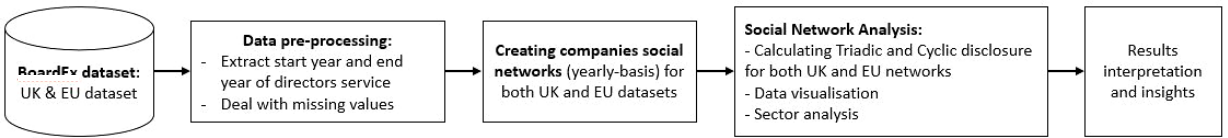
Figure 2. Research Methodology